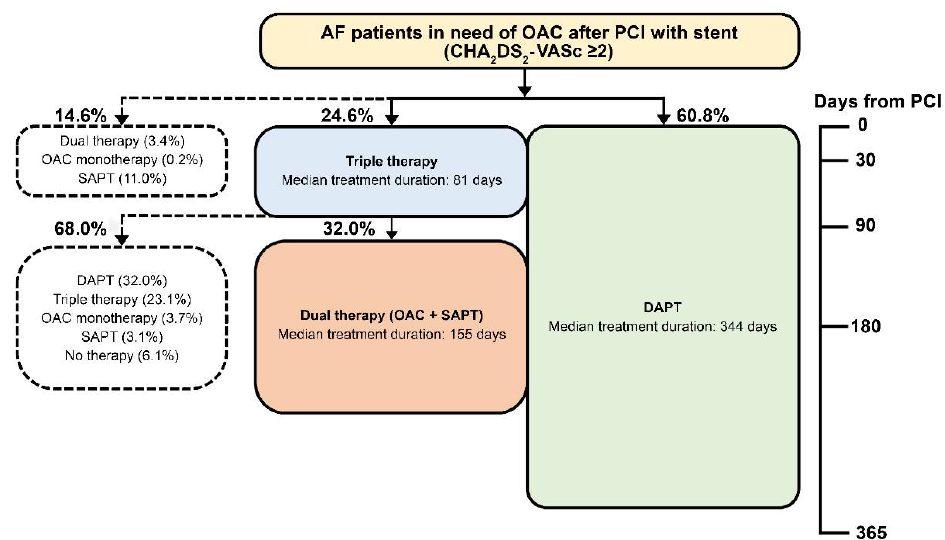
Figure 3. Antithrombotic treatment after percutaneous coronary intervention in patients with atrial